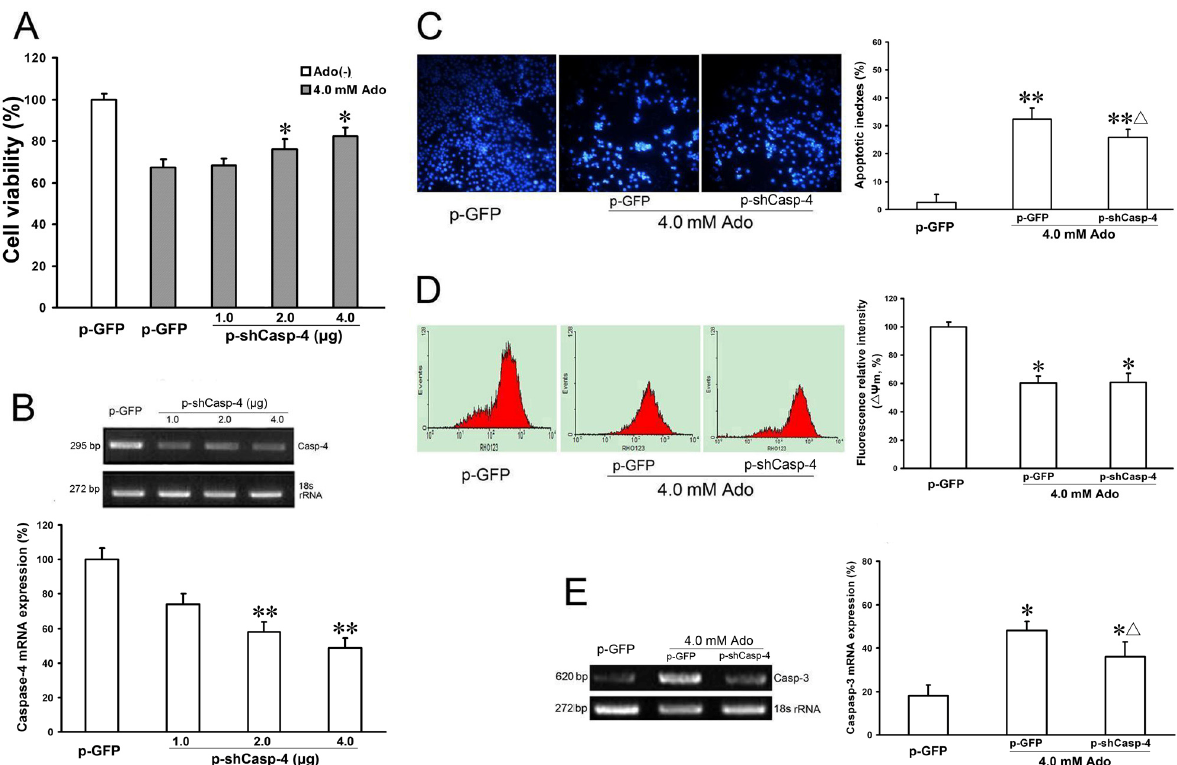
Figure 4. Effects of p-shCasp-4 on caspase-4 mRNA expression and ER stress-related proteins in adenosine-induced apoptosis. HepG2 cells were transfected with either p-GFP (control) or 1.0, 2.0 or 4.0 µg DNA of p-shCasp-4. After incubation for 24 h, cells were incubated with or without 4.0 mmol/L adenosine for a further 24 h, and cell viability was determined by CCK-8 assay ( A ); HepG2 cells were transfected as in panel A. GRP78 mRNA expression was analyzed by RT-PCR. p-shCasp-4 groups showed caspase-4 mRNA expression was down-regulated with increasing doses of plasmid vectors ( B ); HepG2 cells were transfected with either p-GFP (control) or p-shCasp-4. After incubation for 24 h, cells were incubated with or without 4.0 mmol/L adenosine for a further 24 h. The